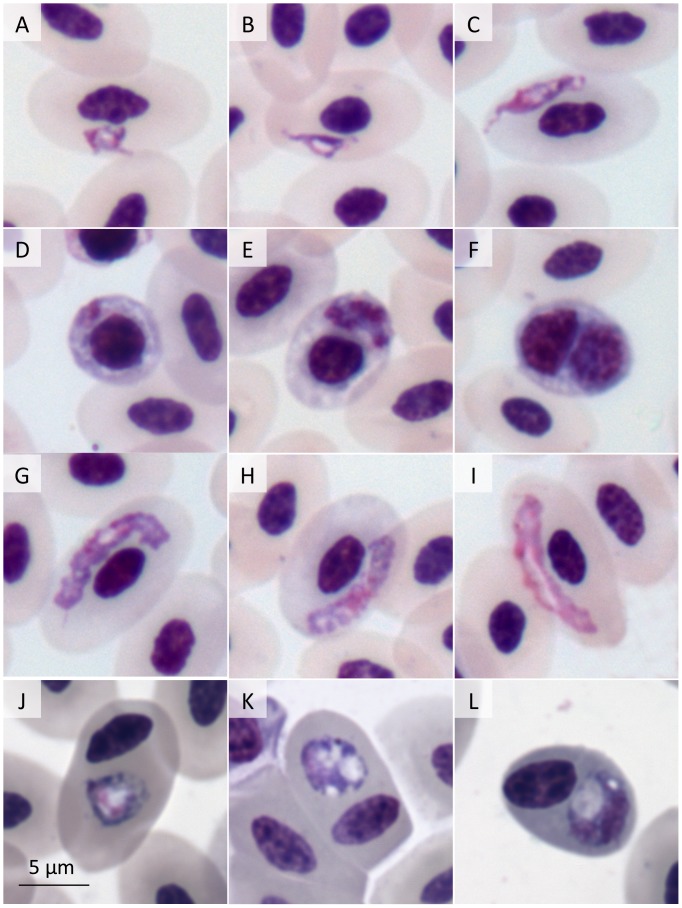
Blood parasites in Giemsa-stained blood smears from Magellanic penguins (Spheniscus magellanicus).
Plasmodium (Huffia) elongatum (508B) trophozoites (a–d), meronts (e,f), macrogametocytes (g,h) and microgametocyte (i); chloroquine-degenerated Plasmodium (Haemamoeba) sp. (503B) (j–l).